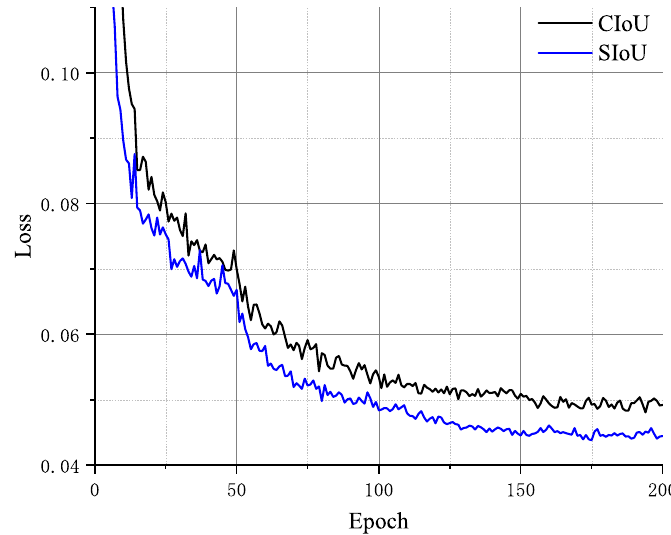
Figure 9. Comparison of CIoU and SIoU in training.